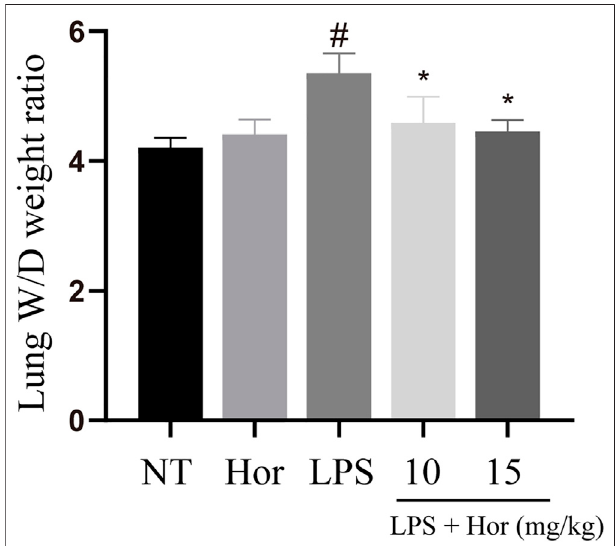
FIGURE2| Hordeninealleviatesthewet-dryratioweightoflungtissuein LPS-induced acute lung injury. Fresh lung tissues were collected at 24 h after the LPSchallenge. Results areshown asmeans ± SD( n (cid:1) 3). # p < 0.01vs. no treatment (NT) group; p p < 0.05 vs. LPS group. Hor: hordenine; LPS: lipopolysaccharide; W/D: